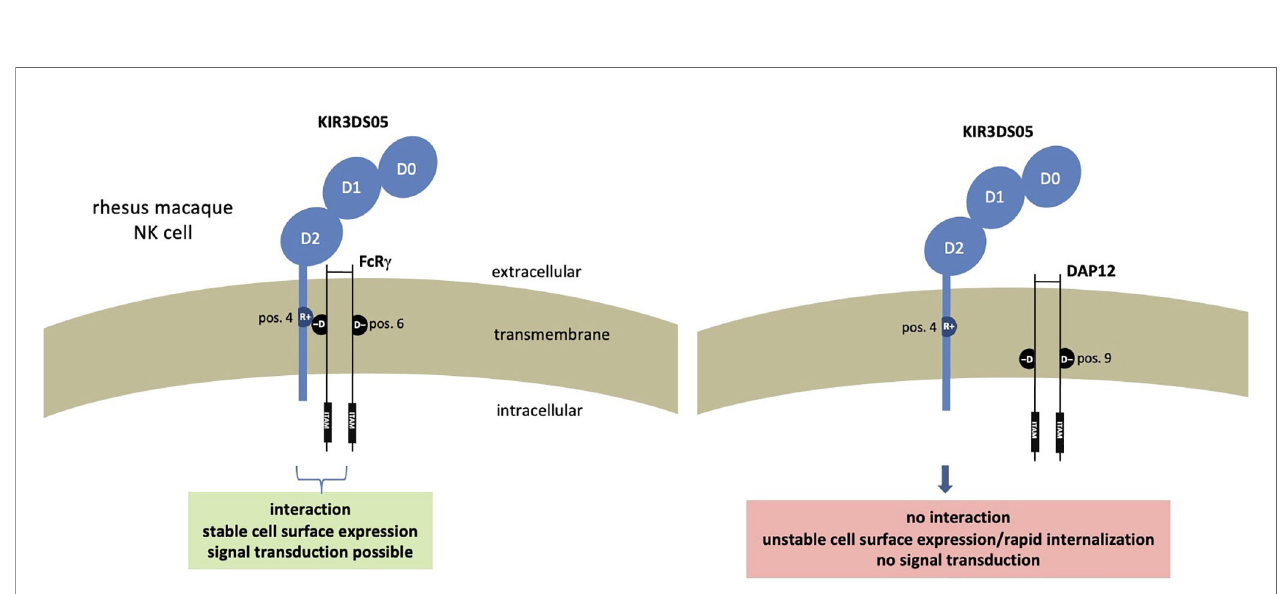
FIGURE 6 | Functional consequences resulting from presence of different adaptor proteins in rhesus macaque NK cells expressing stimulatory KIR